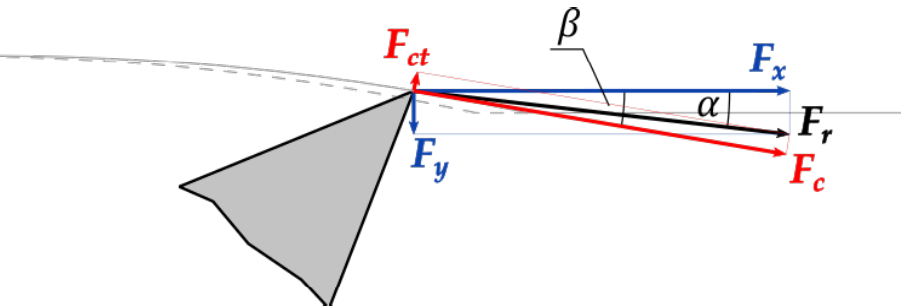
Figure 5. Forces considered in the cutting process. In the presented case, all forces and angles are